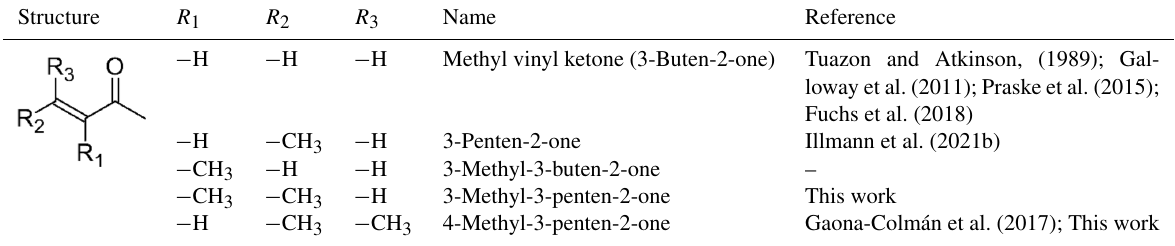
Table 1. Structures of α , β -unsaturated ketones and related literature on the corresponding OH-radical-initiated oxidation mechanism. Structure R 1 R 2 R 3